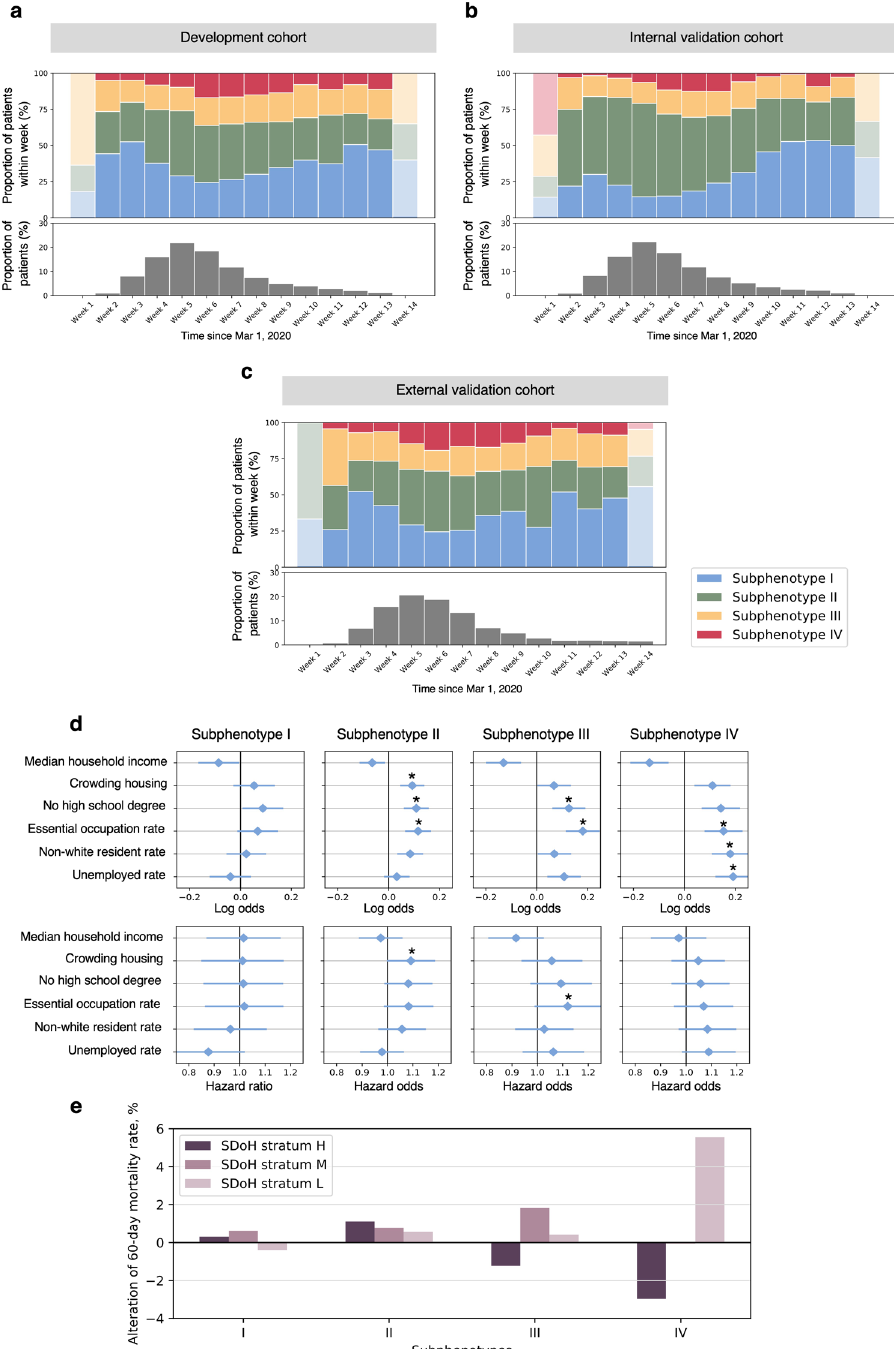
Fig. 4 Plots showing temporal patterns and SDoH implications of subphenotypes. a – c Proportions of subphenotype memberships of patients con fi rmed per week, since March 1, 2020. d Log odds and Hazard ratio (mean values and standard deviation [error bar]) showing associations between individual SDoH characteristics and 60-day mortality risk, using logistic regression analysis and Cox regression analysis, adjusting for age and sex, respectively. e Plot showing alteration of 60-day mortality rate ( Y -axis) of each SDoH stratum to that of subphenotype level. * P -value <